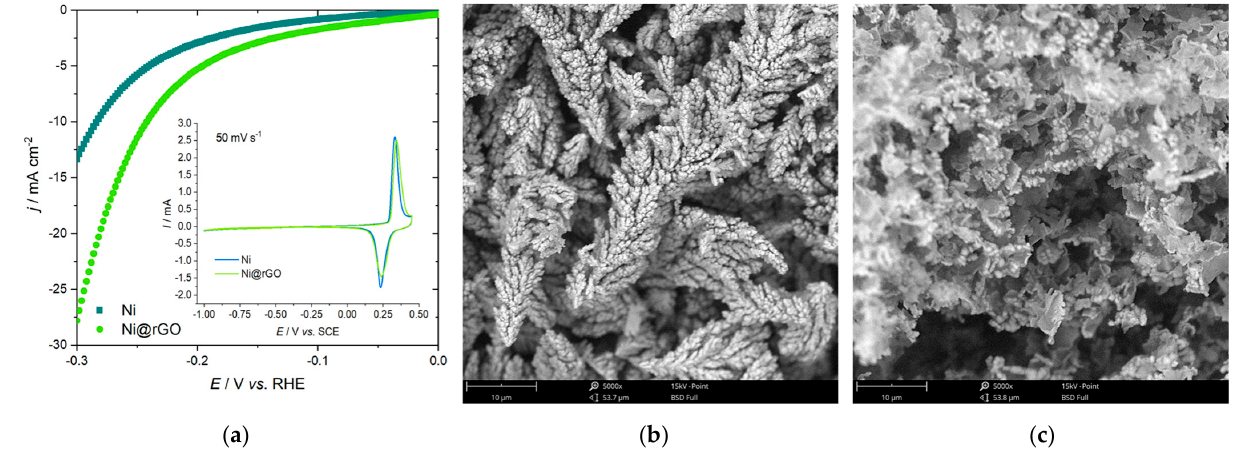
Figure 7. ( a ) HER polarization curves for simultaneously deposited Ni@rGO compared to pure Ni deposit, inset shows cyclic voltammograms of these two electrodes; ( b ) SEM image of pure Ni deposits; ( c ) SEM image of Ni@rGO